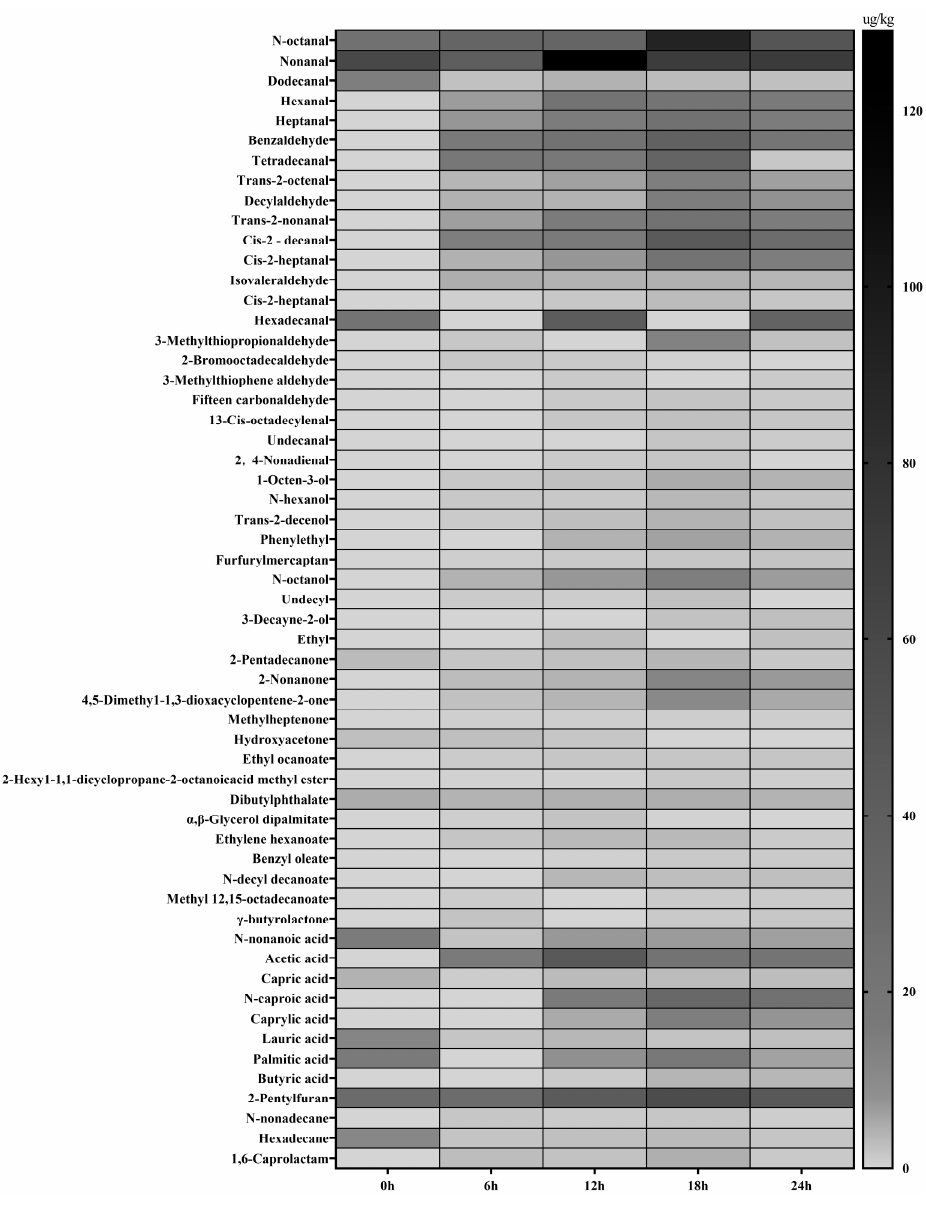
Figure 4. Heatmap of volatile flavour components in fermented sausage at different times.